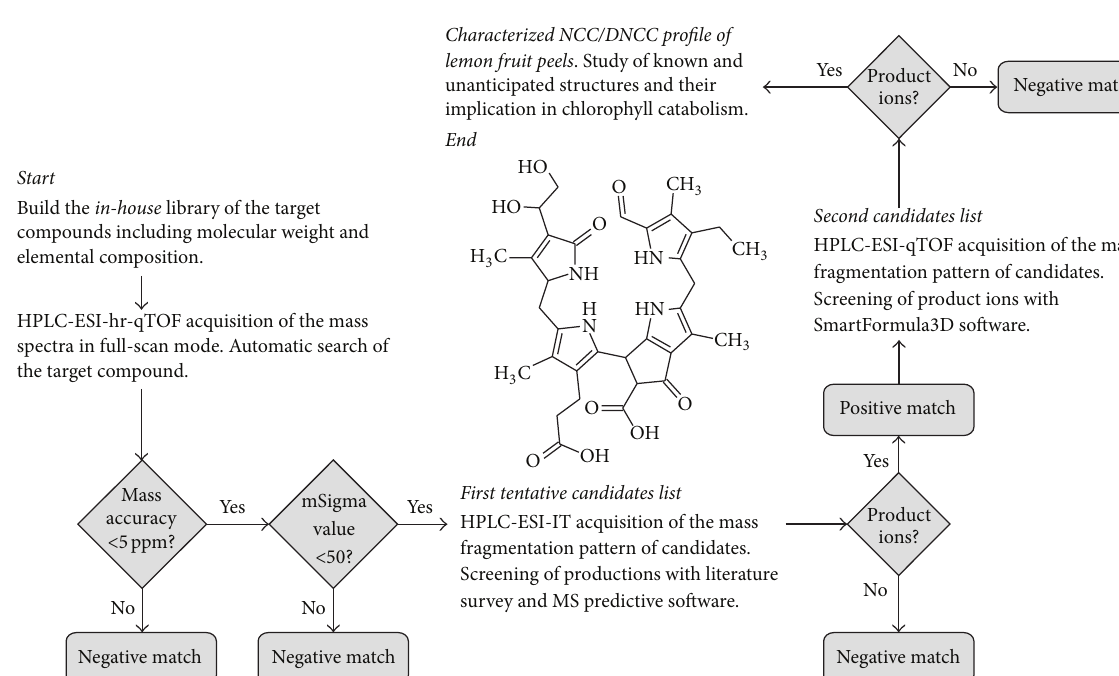
Figure 2: Data evaluation routine of HPLC/qTOF-MS data: to build an in-house library of elemental composition of the target compounds; automated peak detection on the EICs expected for the [M + H] + ions of each compound in the in-house library. The software performs the identification automatically according to mass accuracy and in combination with the isotopic pattern in the SigmaFit algorithm. A first tentative candidates list is obtained. To acquire IT-MS 2 fragmentation pattern of tentative candidates to confirm structural configuration in comparison with literature data and predictive software. A second candidates list is obtained. Acquisition of high resolution ESI-qTOF-MS 2 data to confirm consistency of product ions and to obtain the final characterized NCC/DNCC